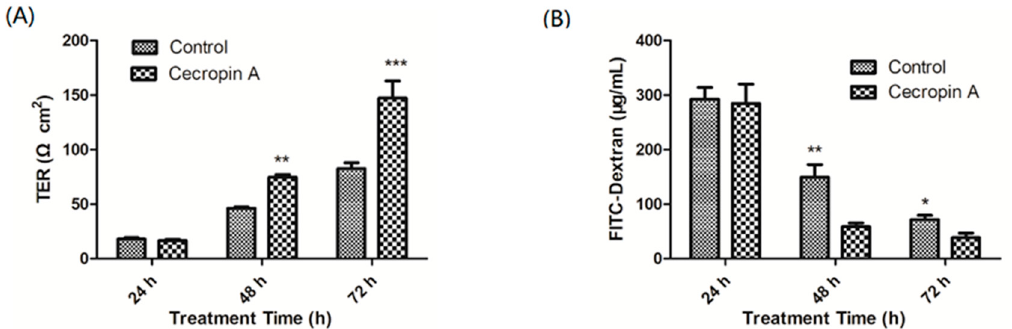
Figure 2. Cecropin A enhances the transepithelial electrical resistance (TER) and reduces the permeability of the IPEC-J2 cell monolayer. The TER (( A ), n = 6) and permeability (( B ), n = 6) of the cell monolayer were tested after treatment with cecropin A for 24 h, 48 h, and 72 h. The results were confirmed by three independent experiments per treatment. Representative results of the three independent experiments are shown. Data (mean ± SEM) were analyzed with the Student’s t -test. * p < 0.05, ** p < 0.01, *** p < 0.001.